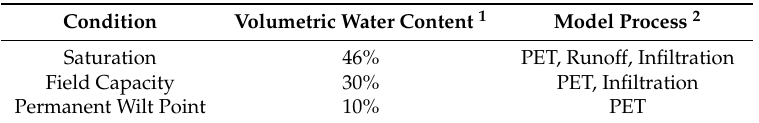
Table 2. Effective root zone soil profile